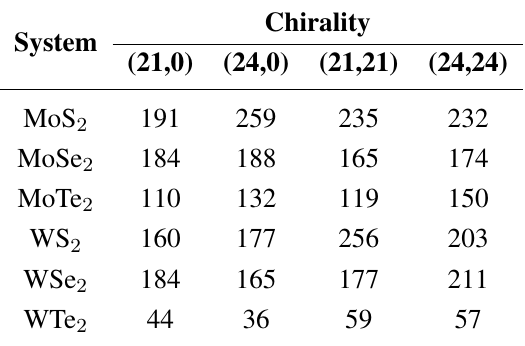
Table 1. The calculated Young’s moduli of all the studied NTs. The numbers are obtained from the harmonic approximation following Hooke’s law for small values of tensile strain.